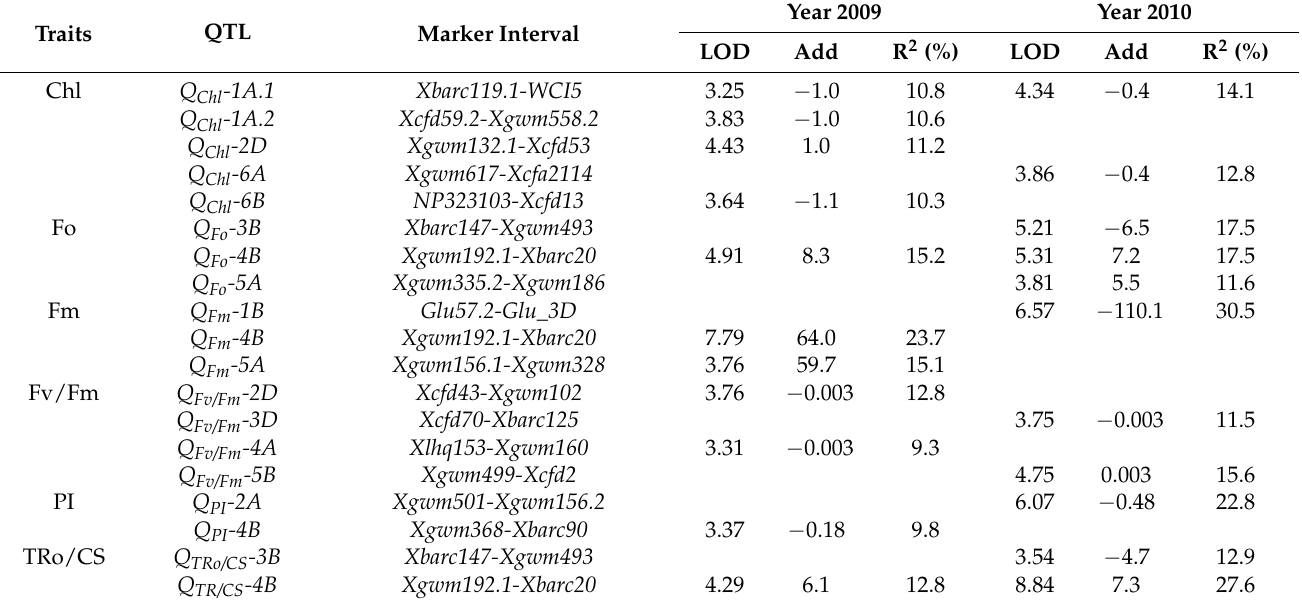
Table 2. Summary of the QTL for the photosynthetic traits in flag leaves detected with